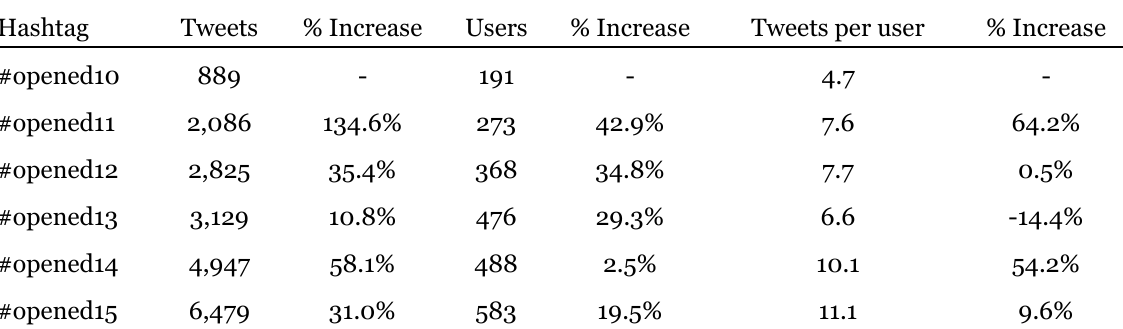
Open Education Conference Tweet Frequencies by